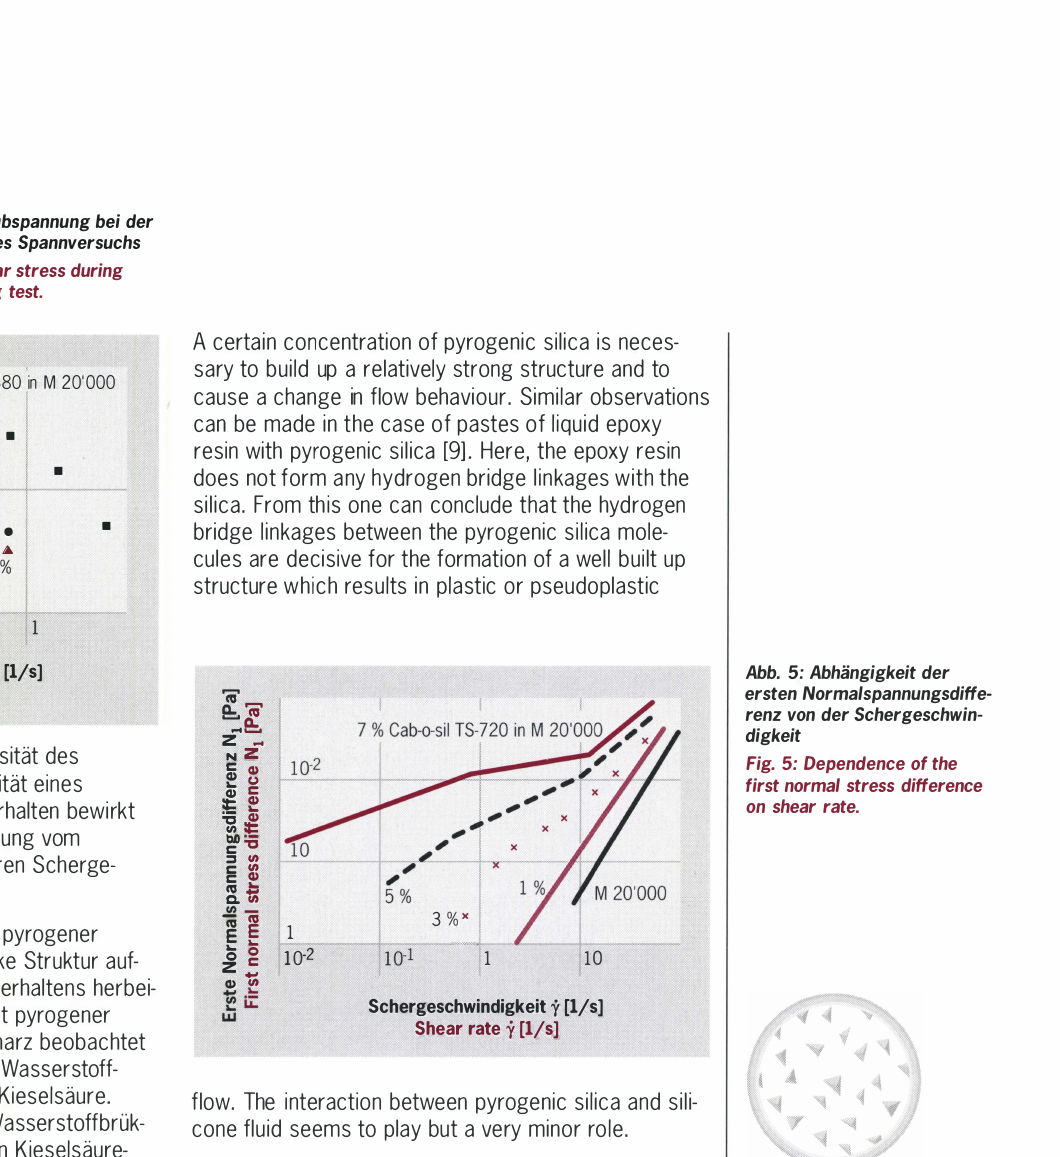
Fig. 4: Dependence of relative residual shear stress during relaxation on the shear rate of the clamping test.